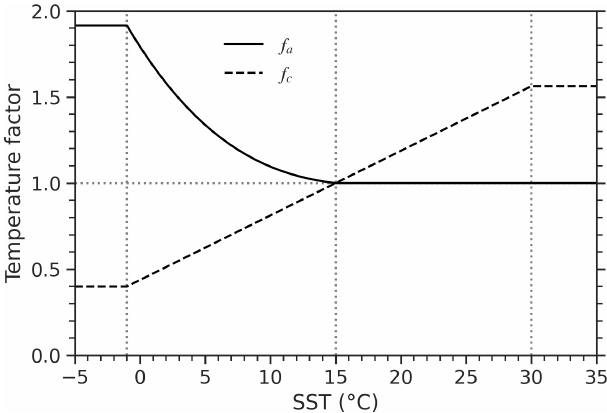
Figure 1. Temperature factors f a and f c for the formation of sea- spray particles in the accumulation and coarse modes,